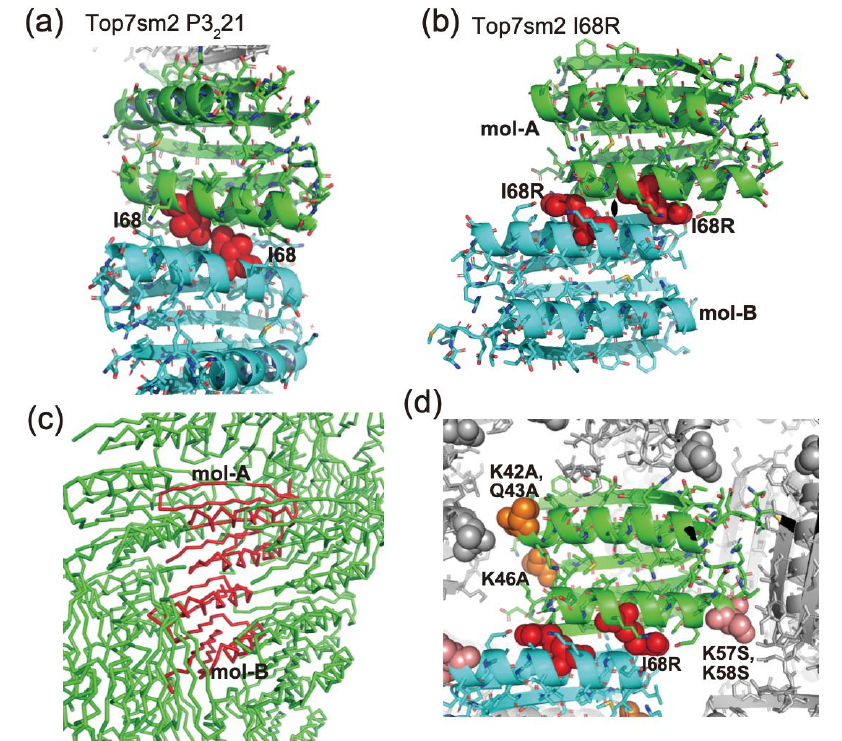
Figure 3. Mutant design and crystal structure of Top7sm2-I68R. ( a ) Intermolecular packing of Top7sm2 P3 2 21, which is commonly shared in other Top7 crystals. I68 residues are shown in red with sphere representations. ( b ) Crystal structure of Top7sm2-I68R. Two molecules in the asymmetric unit are shown (mol-A: green, mol-B: cyan). Mutated R68 residues are shown in red with CPK representations. ( c ) Crystal packing of Top7sm2-I68R structure. Two molecules in the asymmetric unit are shown in red ribbon representation. ( d ) Close view of the crystal packing. Surface mutations in sm1 (K42A, Q43A, and K46A) are shown in orange and those in sm2 (K57S and K58S) are shown in pink. Symmetry-related molecules are shown in gray.